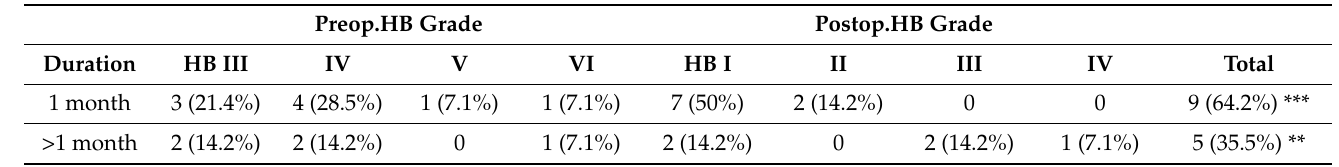
Table 1. Facial function before and after removal of cholesteatoma and facial decompression surgery